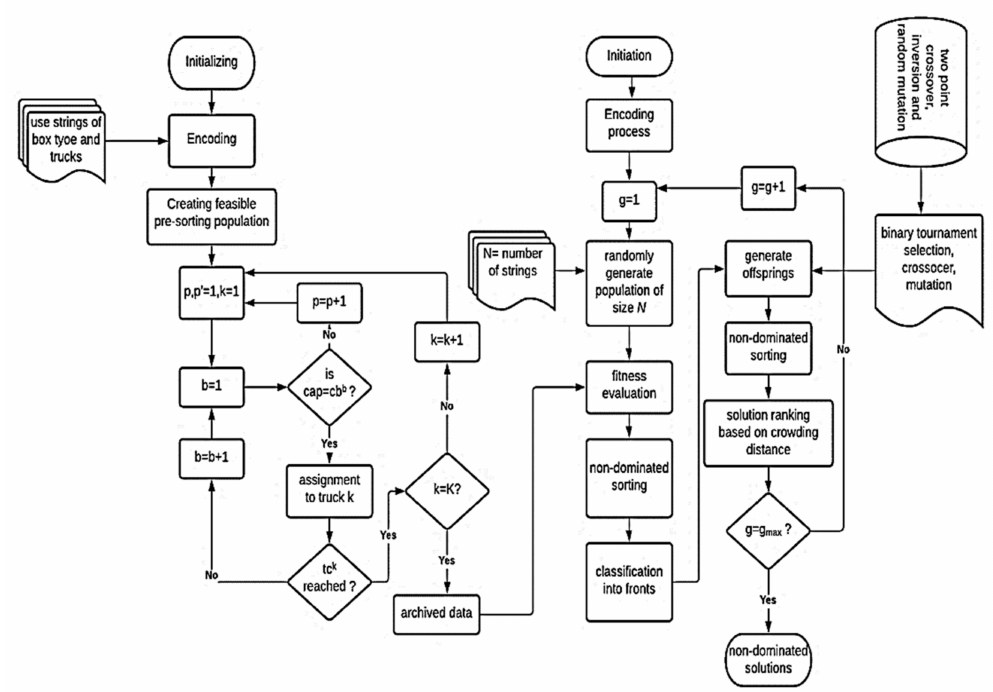
Figure 3. Framework of adaptive NSGA-II (aNSGA-II) algorithm.